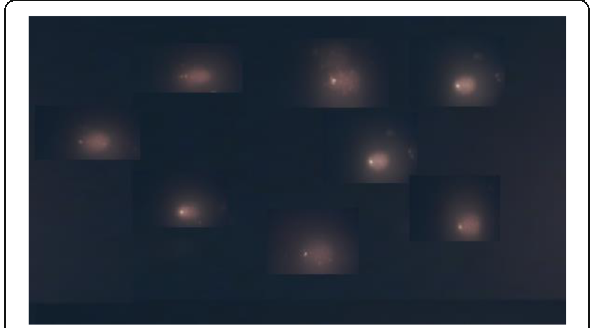
Fig. 2 Comet assay of OP poisoning cases before treatment showing maximum